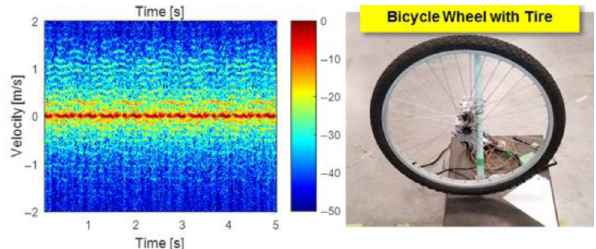
Figure 16 Micro-Doppler measurement of bicycle wheel in 180 ° observation angle under the rotation speed of 66 rpm